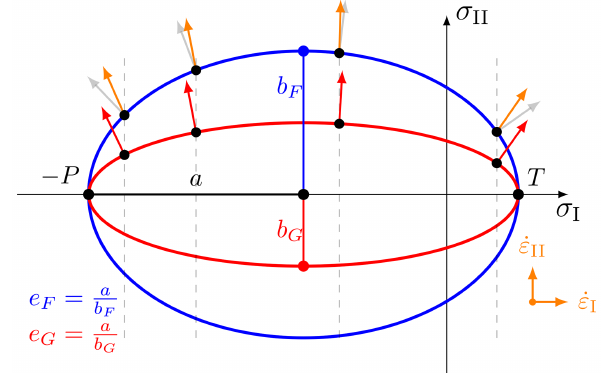
Figure 2. Elliptical yield curve with a non-normal flow rule, a yield curve ellipse aspect ratio e F = 2 (blue), and a plastic potential el- lipse aspect ratio e G = 4 (red). The gray and orange arrows show the normal and non-normal flow rules,